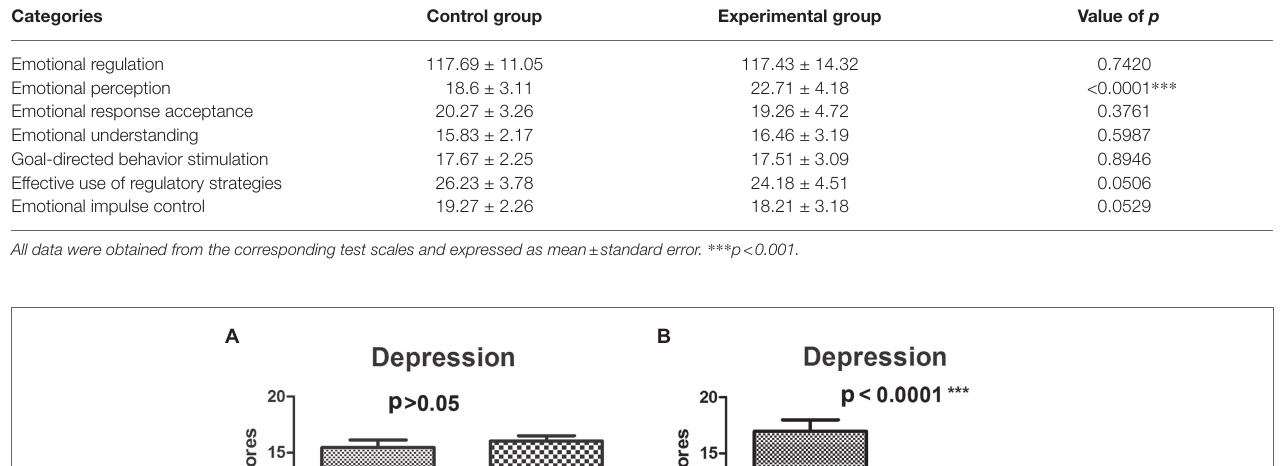
TABLE 1 | Characterization of experimental and control subjects. Categories